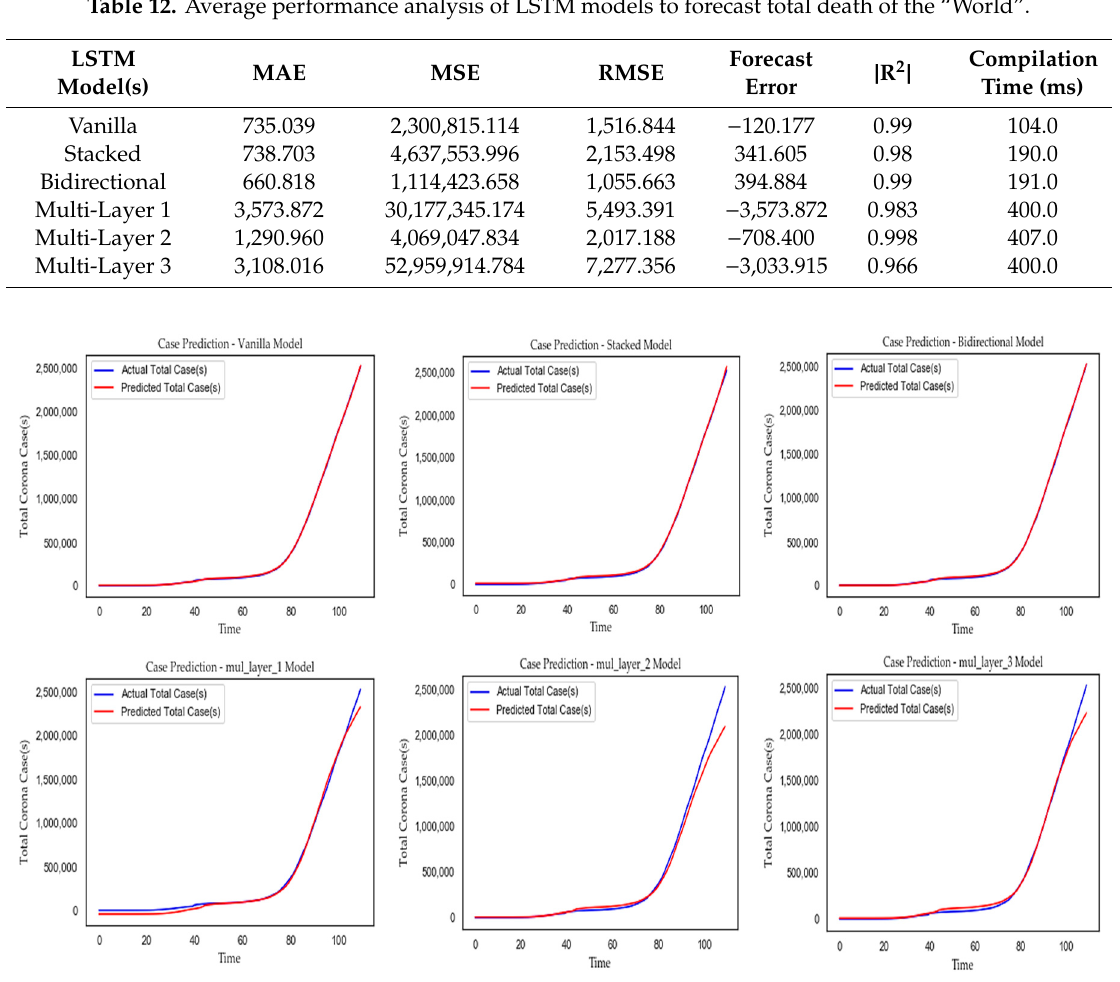
Figure 10. Comparing the calibration of the LSTM models to forecast total cases of the “World”.